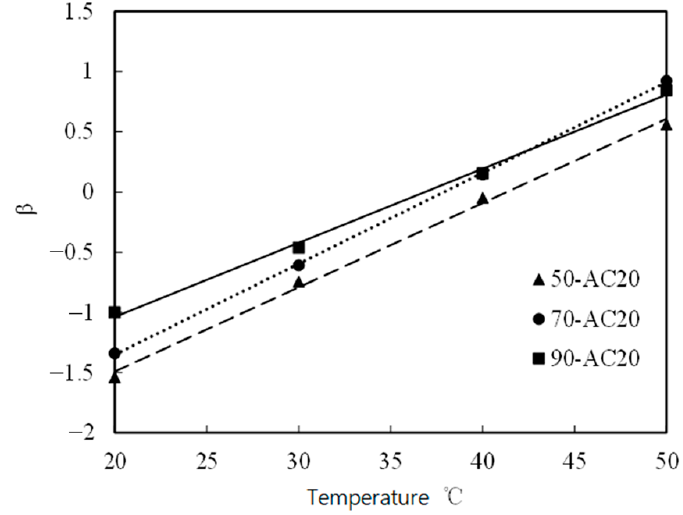
Figure 4. Relationship between shape parameter β and temperature.